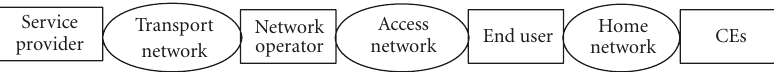
Figure 1: Telecommunication network infrastructure for o ff ering